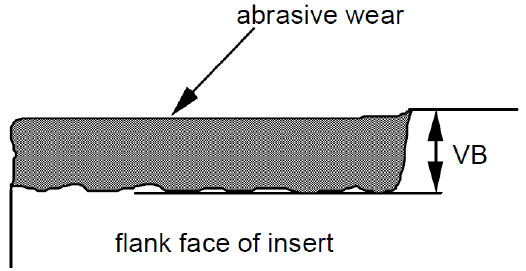
Figure 3. Tool wear VB as it is seen on the insert.